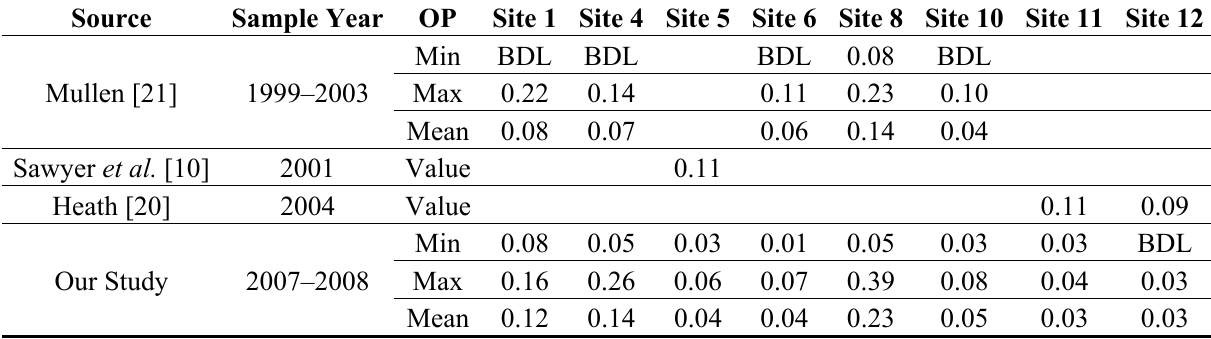
Table 3. Minimum, maximum, and mean (if available) of orthophosphate (OP) concentrations from historical sources in chronological sampling order, with coinciding sites, along with our